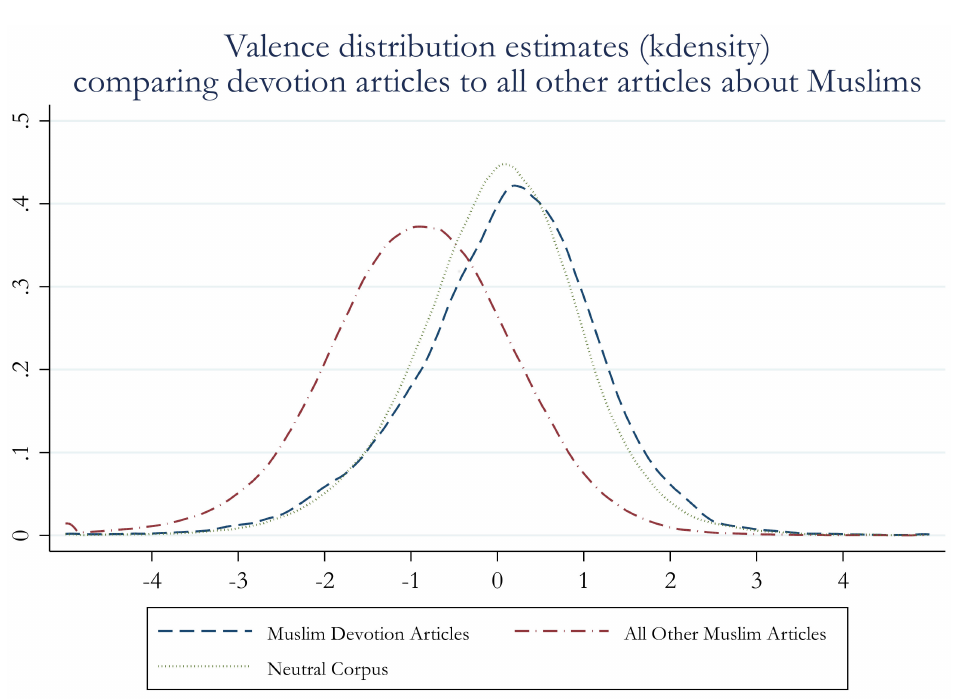
Figure 1. Valence distributions for Muslim devotion sub-corpus articles, all other Muslim corpus articles, and the neutral